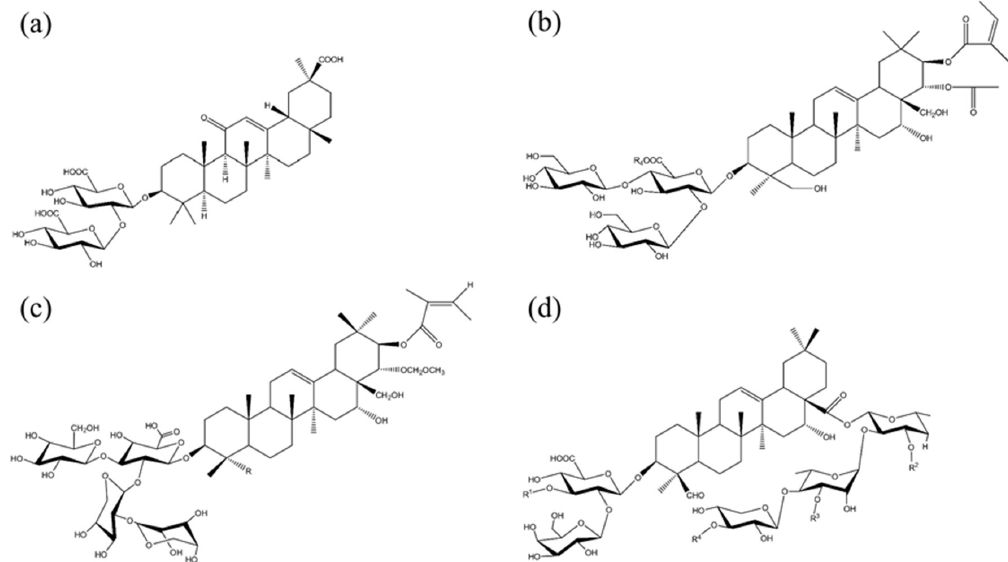
Figure 1. Molecular structures of three monodesmosidic saponins, glycyrrhizic acid ( a ), escin ( b ) and tea saponin ( c ), and bidesmosidic saponin Quillaja saponin ( d ).